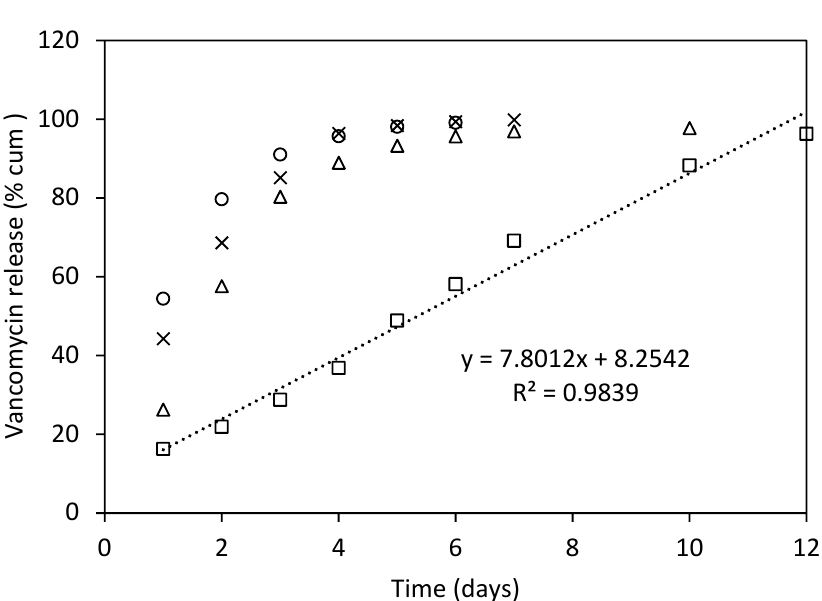
Figure 9. Vancomycin hydrochloride releases from bone graft impregnated with an aqueous so- lution (circle), a hypromellose gel (cross), a water-in-oil emulsion (triangle), and a PLGA solid dispersion